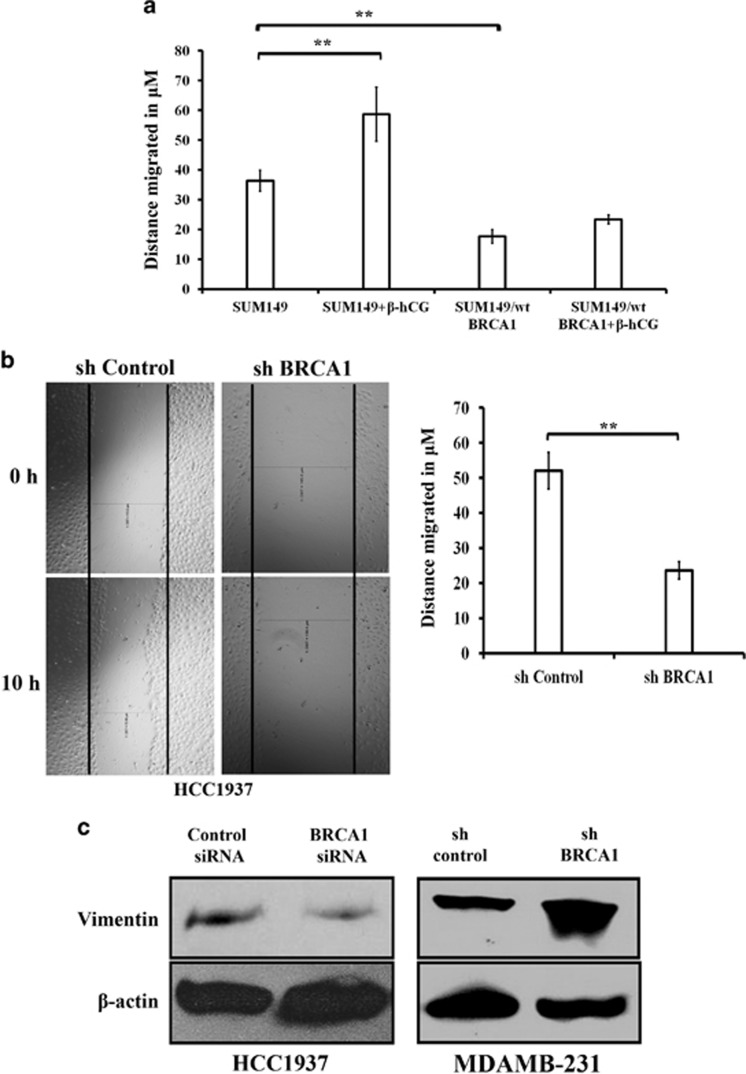
Mutant BRCA1 augments β-hCG induced migration in BRCA1 defective cells. (a) Wound healing assay of SUM149 and SUM149/wt BRCA1 upon supplementing exogenous β-hCG. Graph represents the distance migrated by cells in μm. (b) Wound healing assay of sh control and sh BRCA1 silenced HCC1937. Graph on the right panel represents the distance migrated by cells in μm. (c) Western blot analysis of the vimentin upon silencing BRCA1 in HCC1937 and MDAMB-231 by siRNA and shRNA respectively. Control siRNA and sh control served as control for HCC1937 and MDAMB-231, respectively.